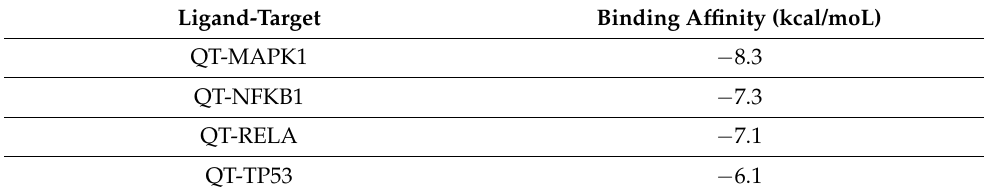
Table 2. Ligand–Target binding